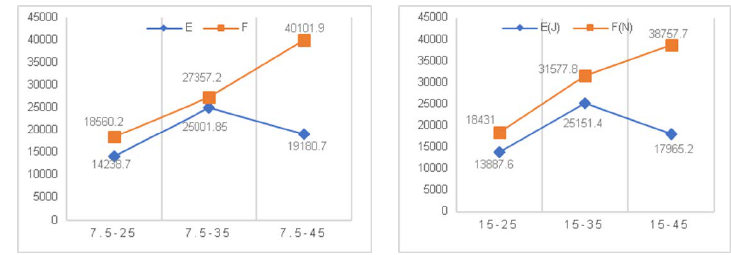
Fig. 6 Data of small particles hitting large particles at position 1 ‘waterfall inlet’